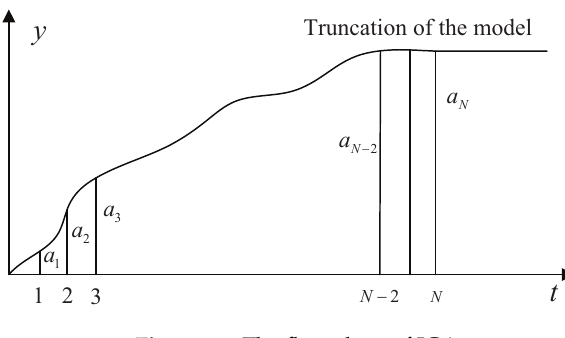
Figure 11. The flow chart of